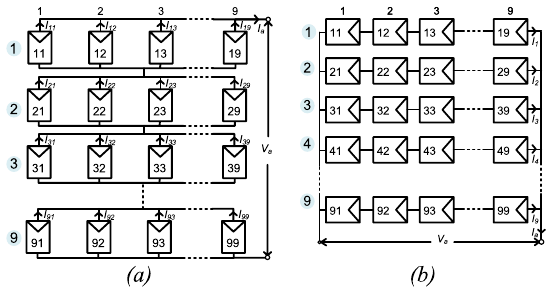
Fig. 2 PV arrays based on 9 ( b )